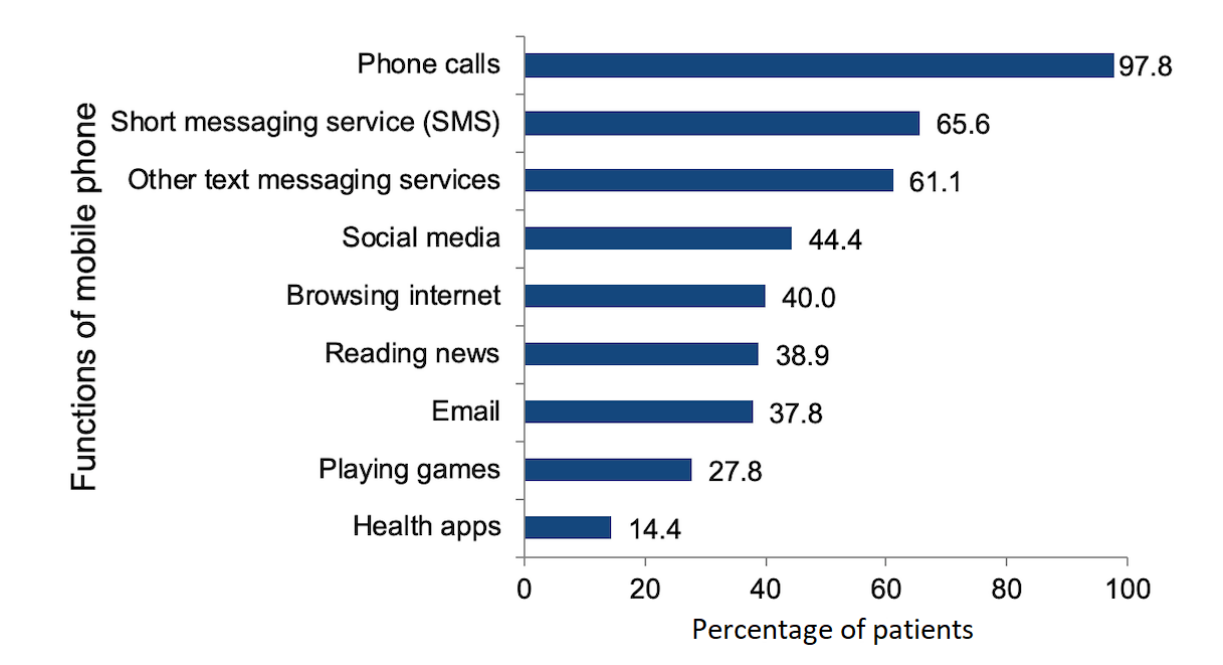
Figure 2. Phone usage activities amongst mobile phone owners.